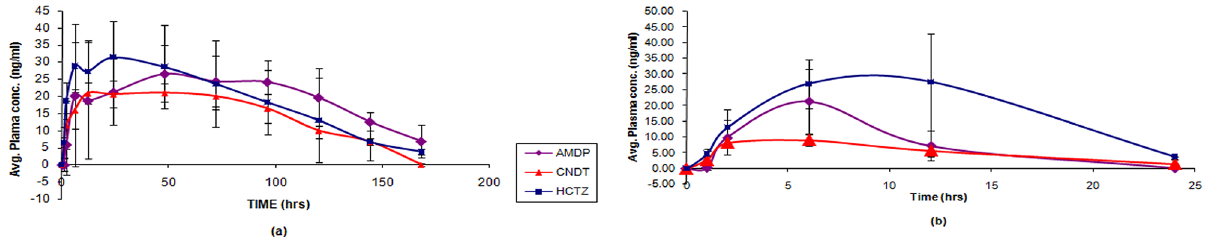
Fig 5. PK profile of: (a) The developed NanoFDC and (b) Combination of the free candidate